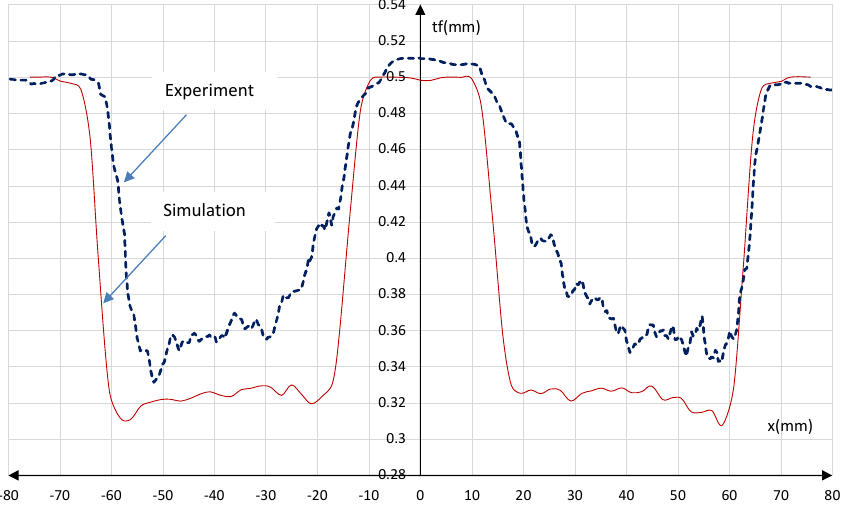
Figure 15. Experimental and FE numerical thickness distributions for depth h = 60 mm. The obtained profiles shape for h = 60 mm (Figure 16) give correct shapes without warping often caused by heating. The uniformity of heating provided by the warm SPIF setup allows us to obtain parts in dimensional conformity. This is considered as a benefit of this type of heating, because often, we notice that the heating associated with the spring- back phenomenon causes an alteration in the final dimensions of the performed truncated cone. Dimensional conformity is firstly verified by the obtained profiles (Figure 16) and secondly by calculating the relative errors of the profiles compared to the real or theoretical profile presented in Table 5.